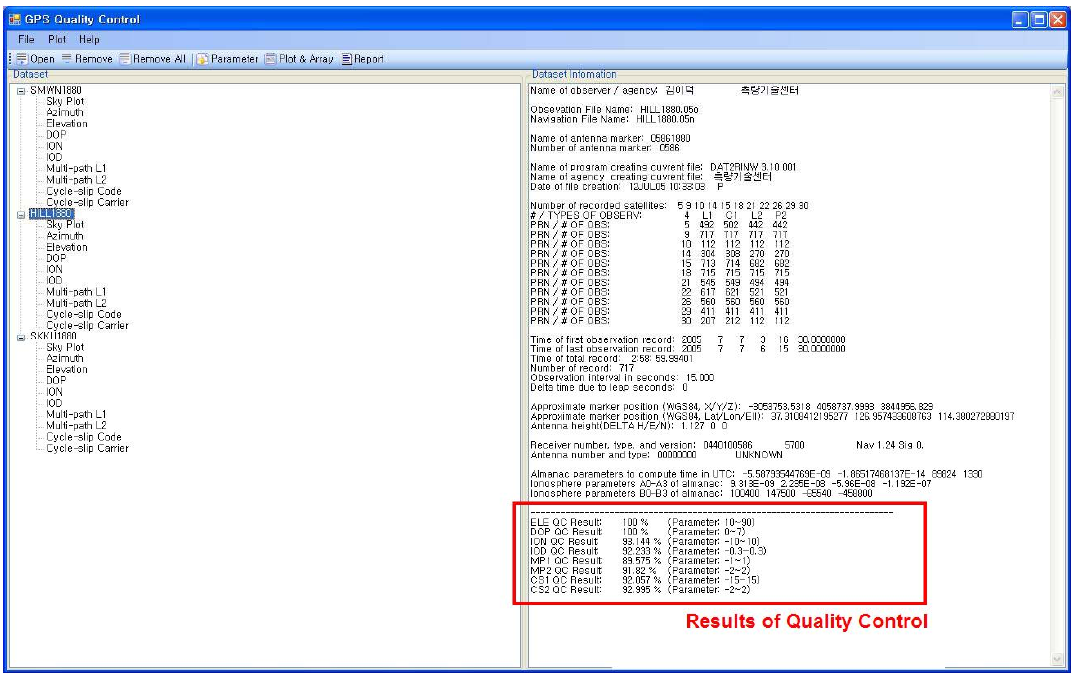
Figure 3. Screen shot of summary report obtained from GPSQC.